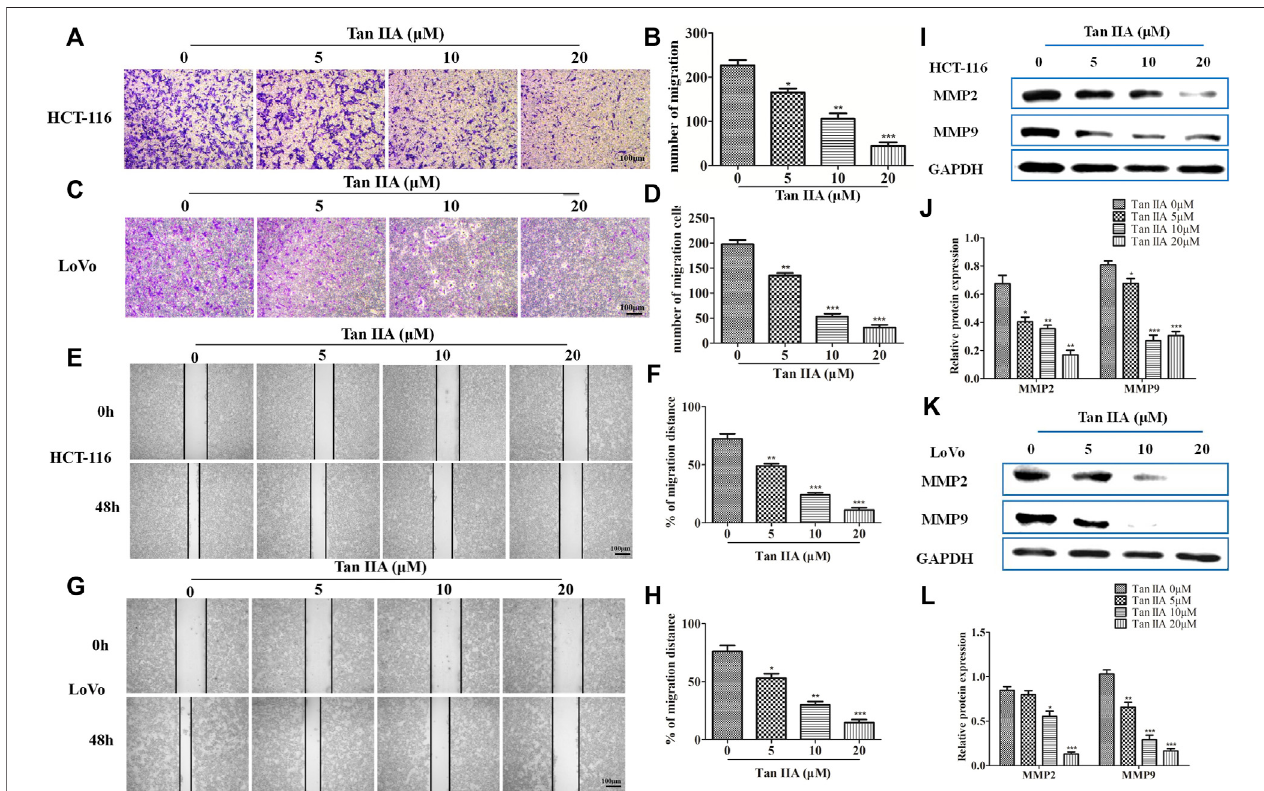
FIGURE3| TanIIAinhibitedthemigrationofCRCcells. (A – D) HCT-116andLoVocellsweretreatedwithdifferentconcentrationofTanIIA,andtranswellassaywas usedtodetectthemigratorycellscountedfrom fi verandommicroscopic fi elds.Theexperimentwasperformedthreetimeswithsimilarresults.* p < 0.05;** p < 0.01;** p < 0.01, compared with group without treatment of Tan IIA. (E – H) HCT-116 and LoVo cells treated with or without Tan IIA for 48 h, the wound-healing assay data were shown. The black lines were used to mark the borders of the scratches, * p < 0.05; ** p < 0.01; ** p < 0.01, compared with group without treatment of Tan IIA. The data were presented as the mean ± SD from at least three experiments. (I – L) The expression of MMP-2 and MMP-9 examined by Western blot, * p < 0.05; ** p < 0.01; ** p < 0.01, compared with group without treatment of Tan IIA. The data were from at least three experiments.